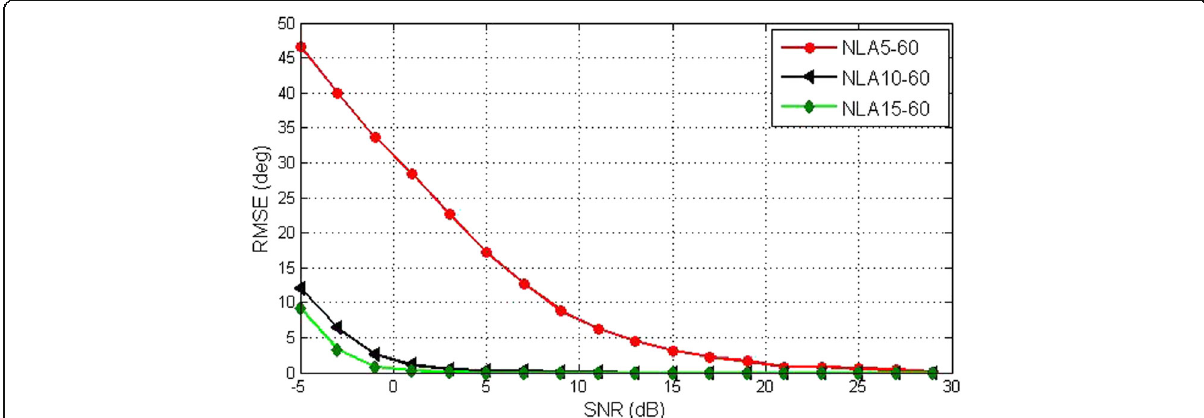
works on a matrix with lower dimensions due to SVD denoising. Impact of aperture length and sensor number on the performance of proposed method was also inves- tigated. The results show that for a fixed number of sensors, the array with longer aperture outperforms arrays with shorter aperture. When the aperture size is fixed, the array with more sensors exhibits better per- formance as more sensors acquire more measurements, which helps sparse signal recovery.